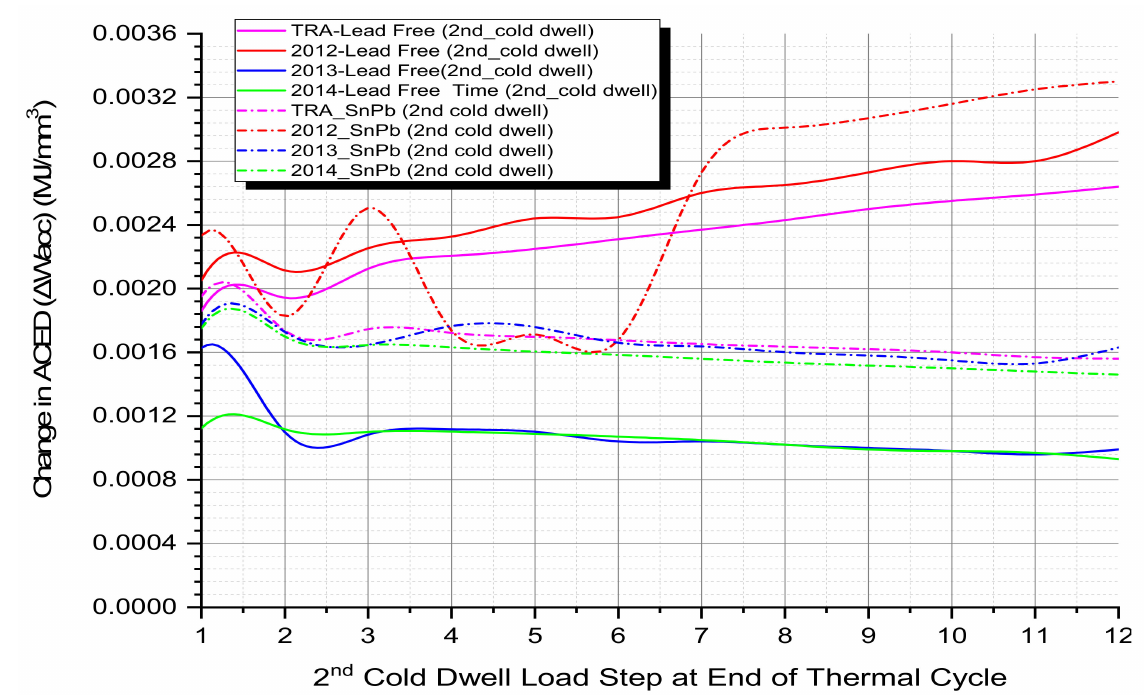
Figure 10. ACED damage accumulation from cold dwell at the end of the thermal cycle (2nd Cold dwell load